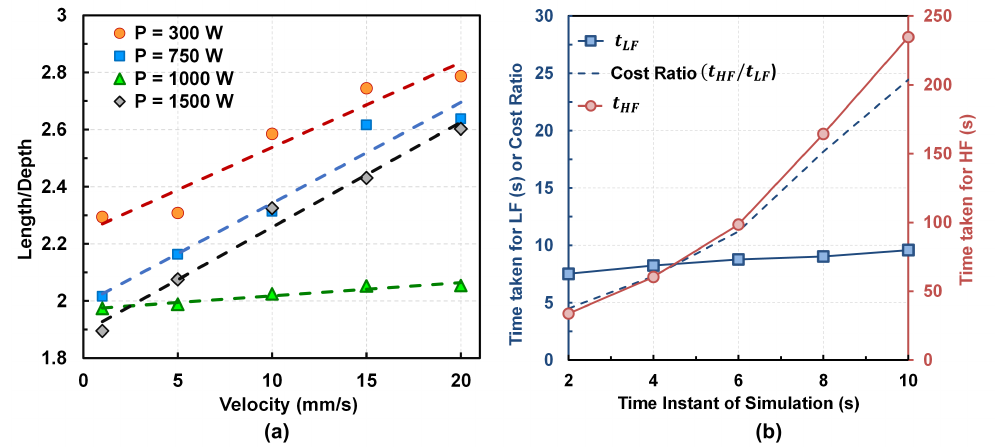
Figure 8. ( a ) The length to depth ratio of the melt pool for different combinations of laser power and velocity. Similar relationships are also observed for the melt pool length and depth and, hence, not shown here for brevity. ( b ) Variation of the cost ratio of HF to LF model at several discrete time instants of the melt pool simulation. Here t LF is the time taken by LF simulations and t HF is the time taken by HF simulations.